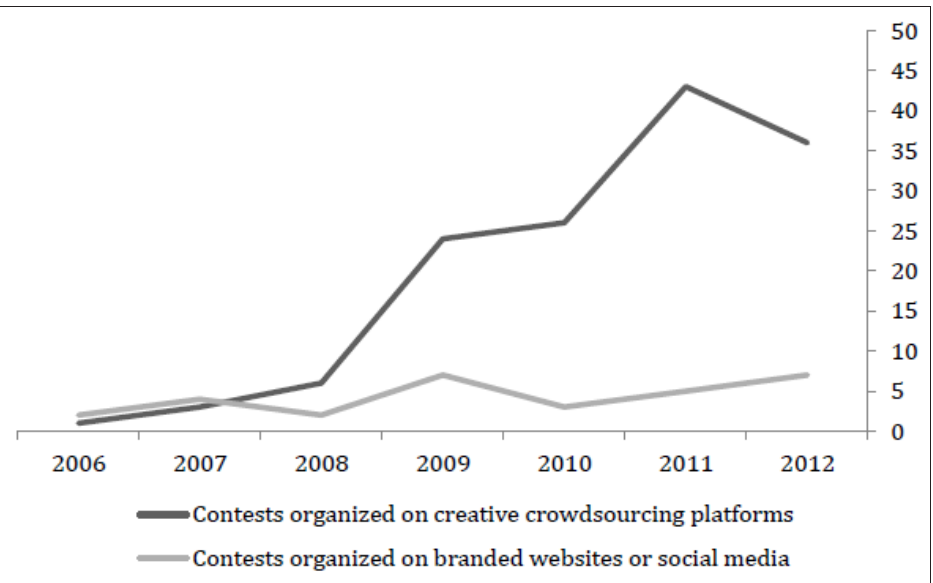
Figure 1: Typology of online contests. Source: (Roth and Kimani,